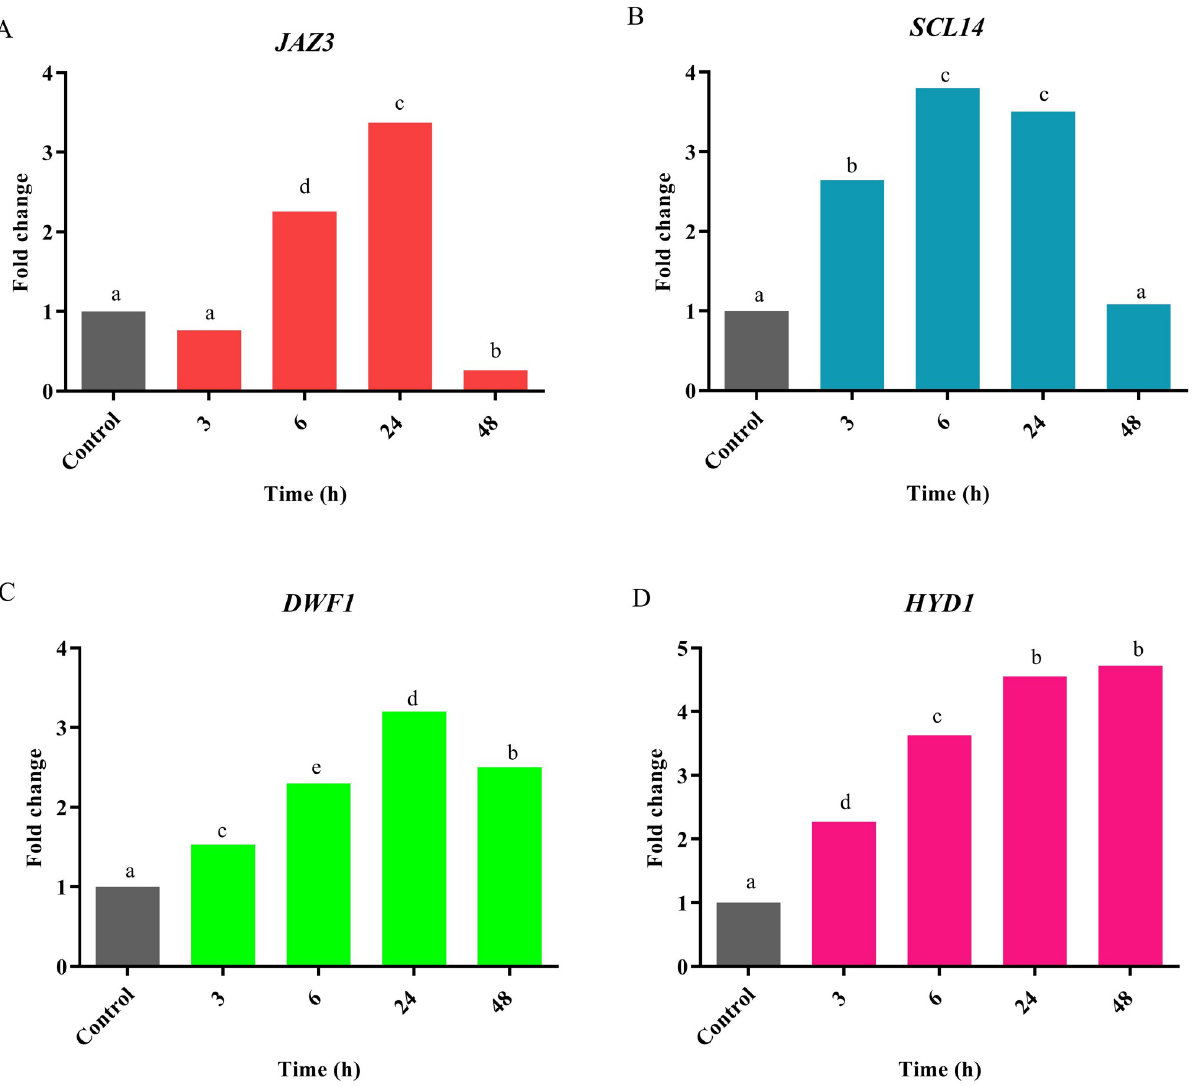
Fig 13. The relative expression of candidate genes. The expression pattern of JAZ3 , SCL14 , DWF1 , and HYD1 was evaluated under 100 μ M MeJA treatment in Digitalis purpurea L. X axis represents the fold change of the expression value. Y axis represents time points. Vertical bars indicate ± SE of the mean (n = 3). The different letters on columns represent the significant difference given by Duncan’s multiple range tests ( P-value � 0.05). There were no significant differences between equal letters ( P-value � 0.05). Although the expression of JAZ3 is early induced, a significant suppression is observed after 48 h. Other key genes particularly SCL14 , targeting DWF1 , and HYD1 , inducing cholesterol biosynthesis and cardiac glycoside content, showed a significant increase in the expression.